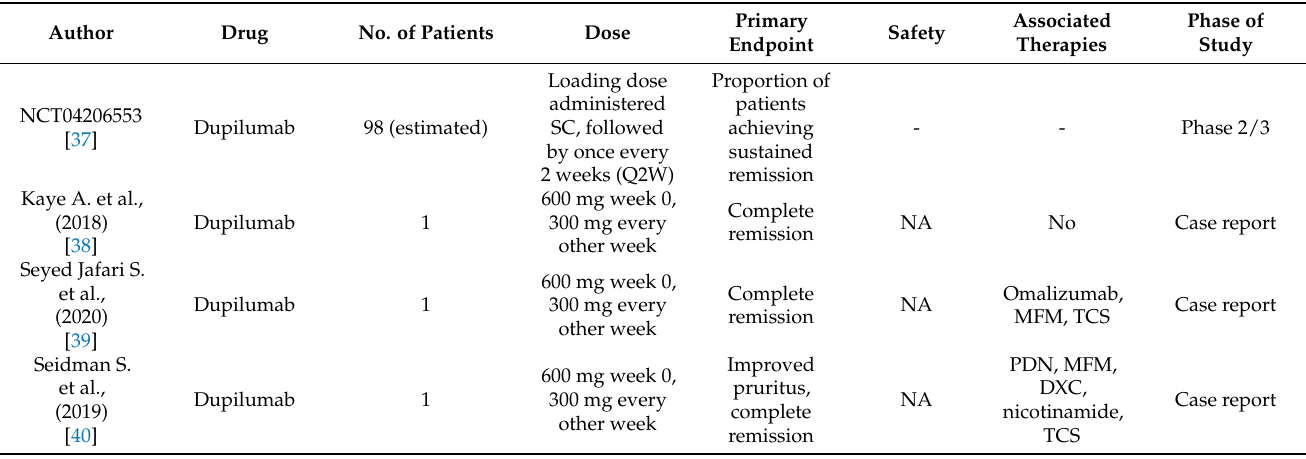
Table 2. Studies summarizing dupilumab use in